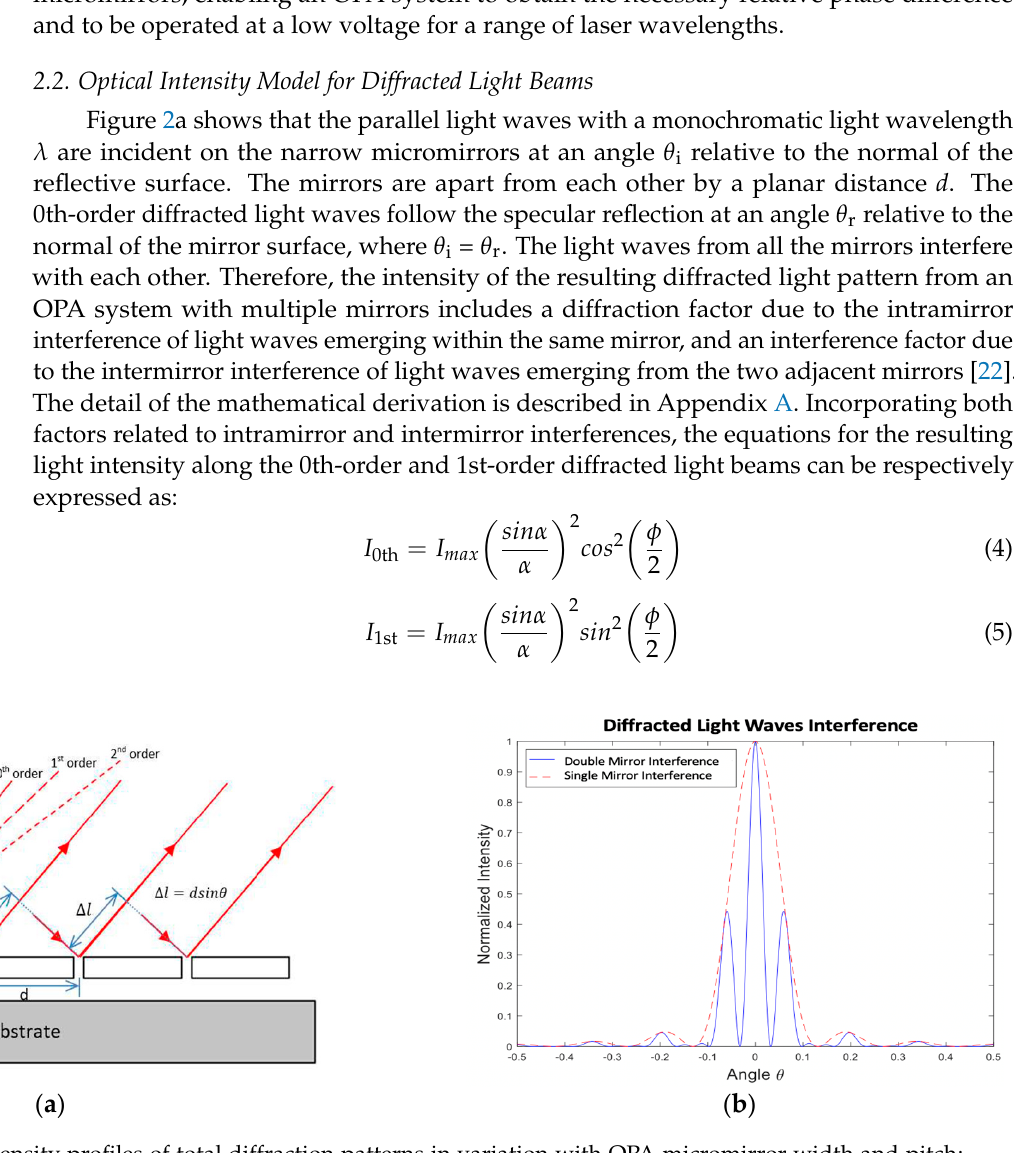
Figure 2. ( a ) Optical-intensity profiles of total diffraction patterns in variation with OPA micromirror width and pitch; ( b ) 1 st -order diffracted light beam profile in variation with micromirror number in a MEMS-based OPA system.